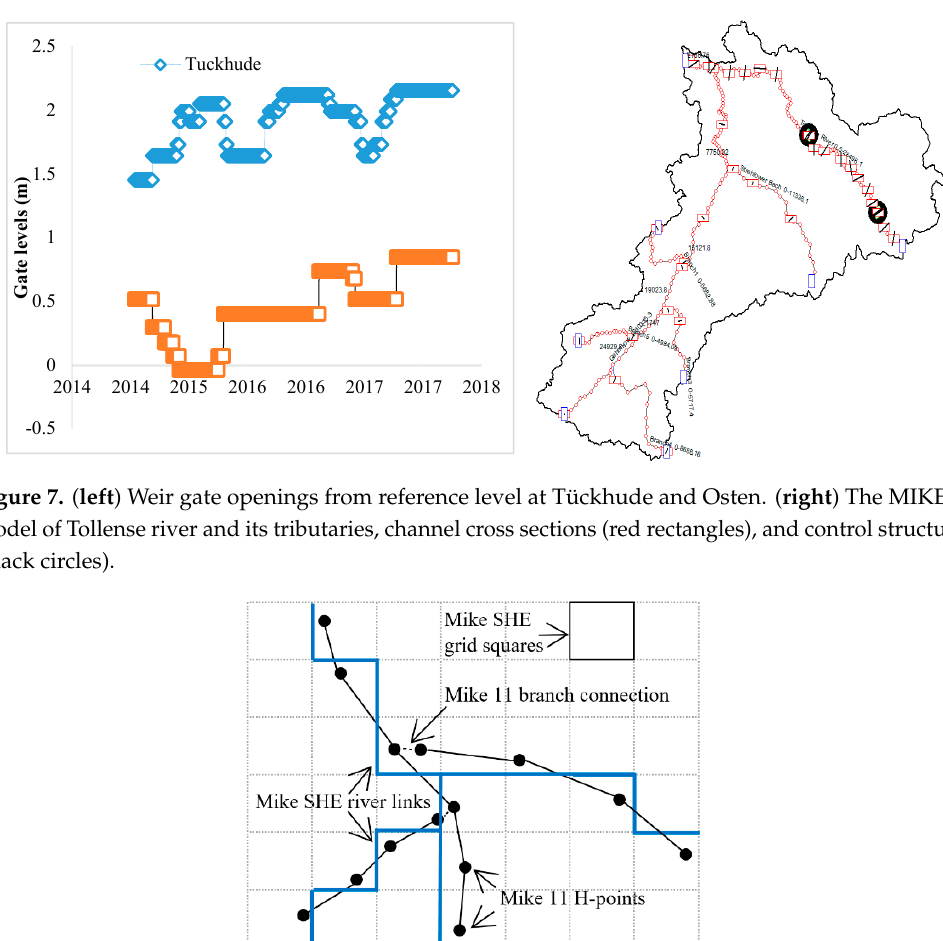
Figure 8. Coupling scheme of a hydrological model MIKE SHE with a hydrodynamic model MIKE 11 based on literature [54].